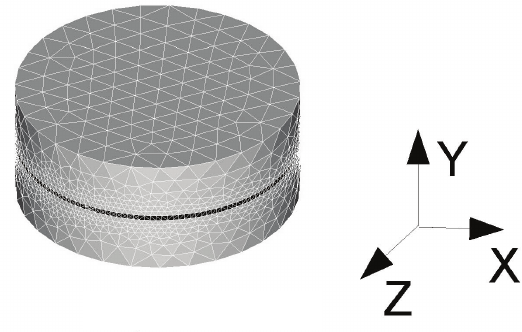
Figure 7: The model used for computation. The finite element mesh can be seen on the surface. The iron oxide layer is sandwiched between two steel disks.